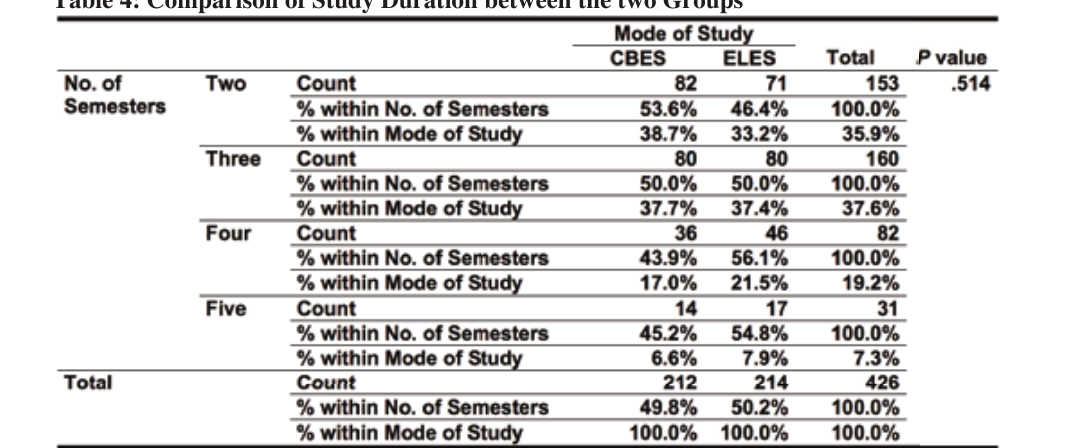
Table 4: Comparison of Study Duration between the two Groups